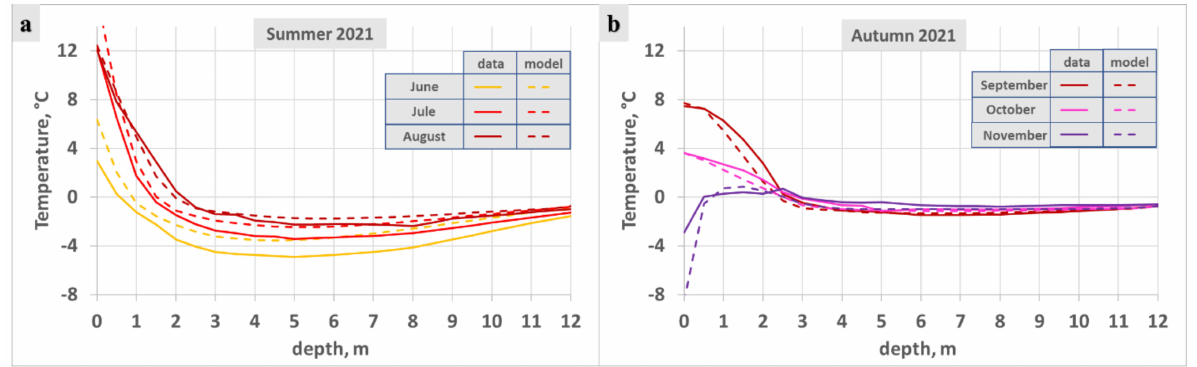
Figure 20. Comparison of temperature profiles in SAM well 48–1 in 2021 in summer ( a ) and autumn ( b